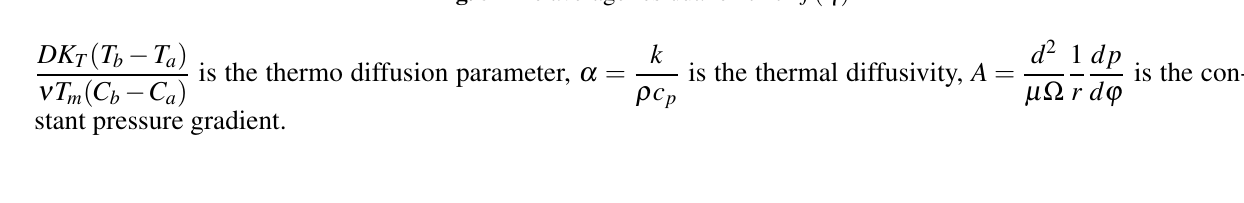
Fig. 5 The average residual error of f ( η